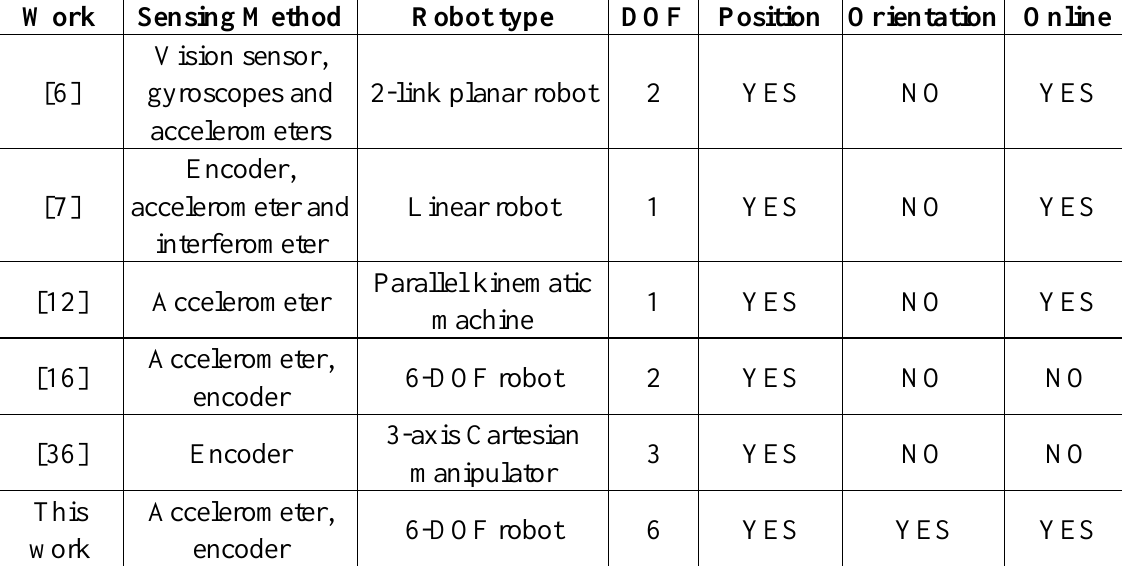
Table 7. Features comparative between the proposal and reported